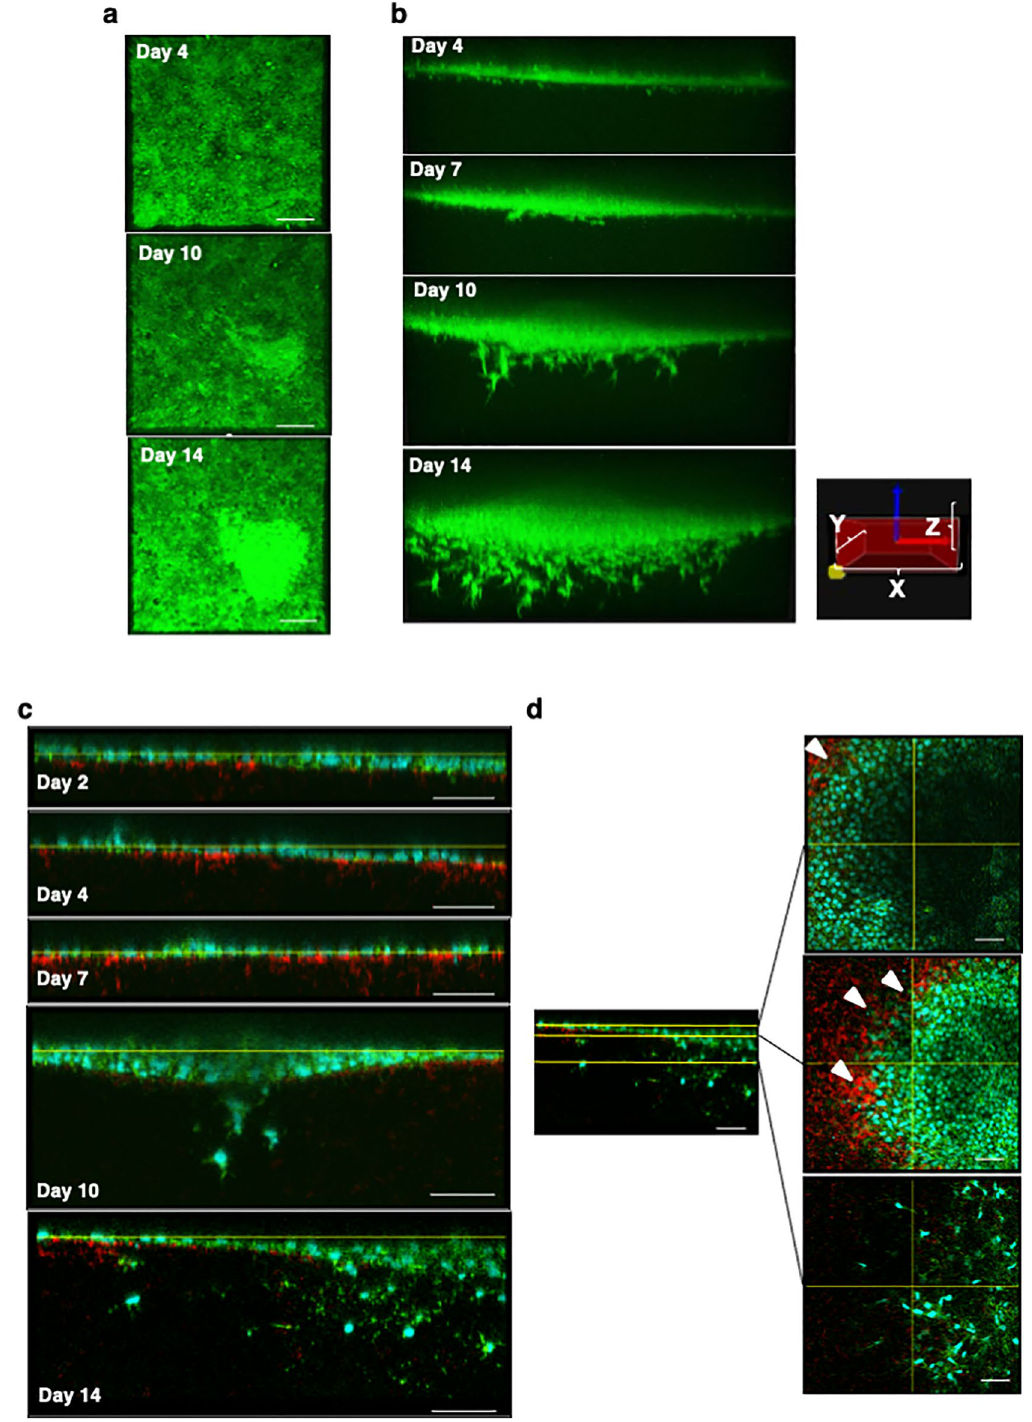
Figure 2. Dynamic behavior of hiPSCs during osteogenic induction. Horizontal ( a ) and vertical ( b ) snapshots of time-lapse imaging during the osteogenic induction of GFP-labeled hiPSCs (W2G) on type I collagen gel. Images were taken at the indicated times. Scale bars = 100 μm in (a) and X, Y: 508 μm and Z: 225 μm in ( b ). Confocal images of hiPSCs (404C2) in vertical ( c ) and horizontal ( d ) views during the osteogenic induction. Sections were stained with Phalloidin (green) and anti-COL 1 antibody (red). Arrowheads show cells surrounded by COL